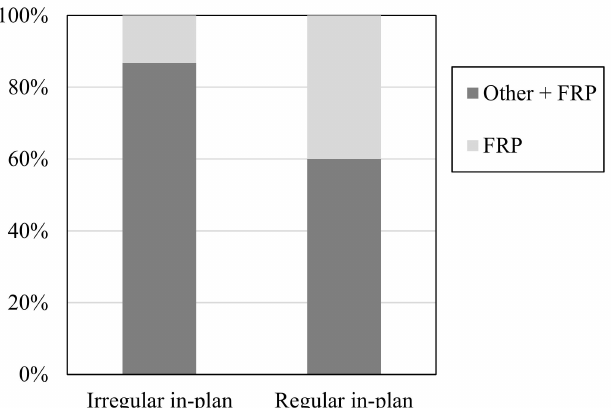
Figure 5. Use of FRPs and other techniques for regular and irregular in-plan